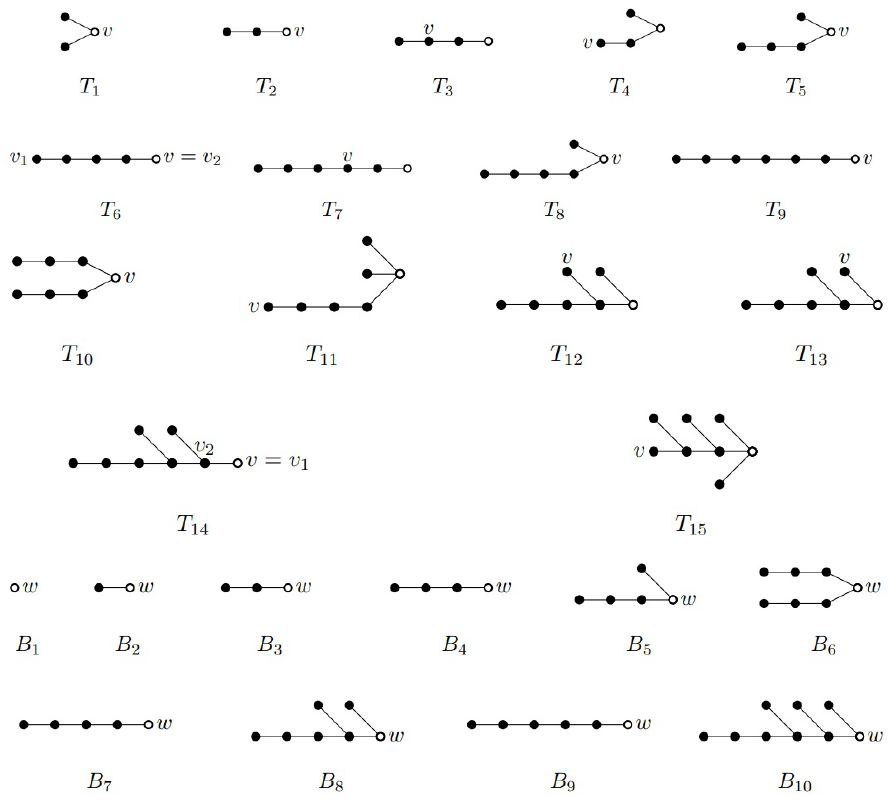
Figure 2. Set A and B